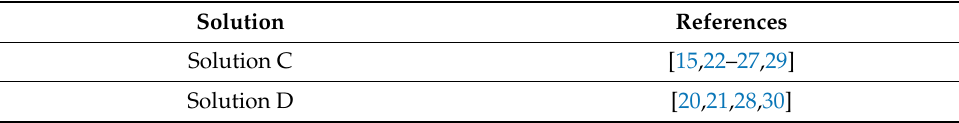
Table 2. References used for preparing Solution C and D.